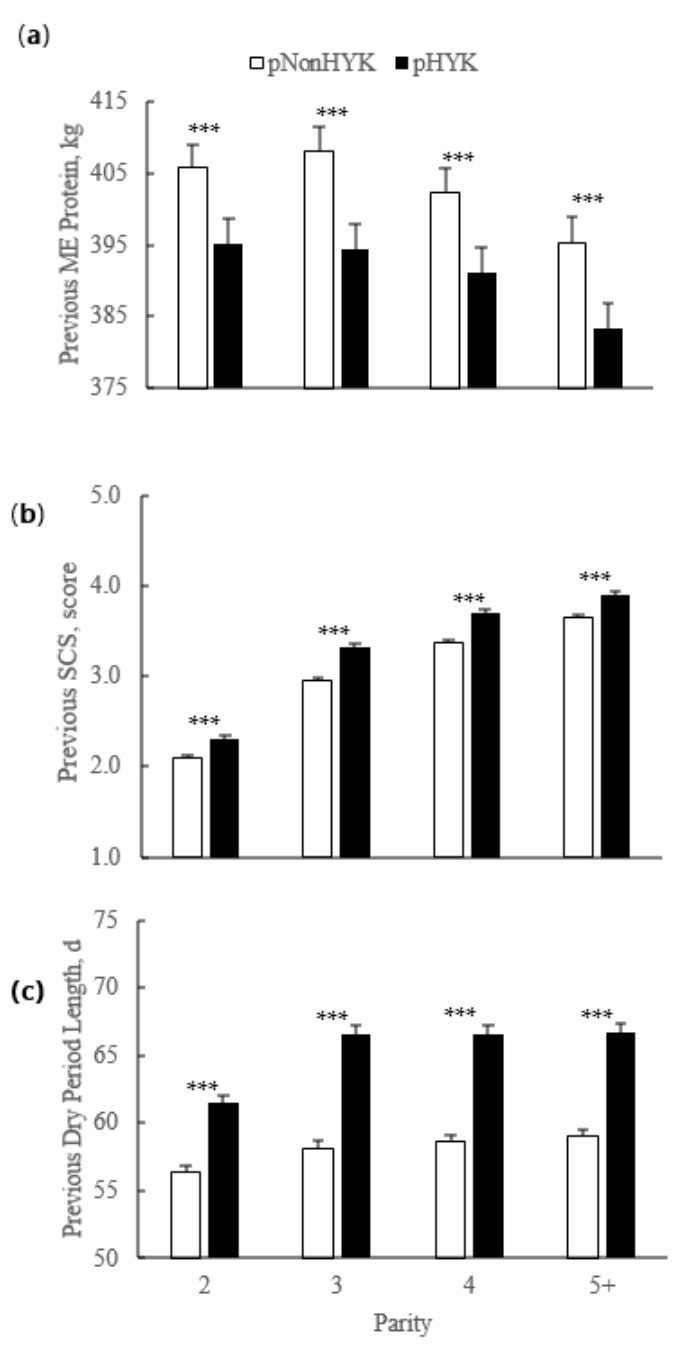
Figure 2. Parity by predicted hyperketonemia (HYK) status interaction on previous lactation ( a ) mature equivalent (ME) milk protein yield (kg); ( b ) somatic cell score (SCS; score); and ( c ) dry period length (d). Blood ß-hydroxybutyrate (BHB) was predicted based on test day milk sample and production variables collected between 5 to 20 days in milk. Predictions were classified as predicted HYK (pHYK; predicted BHB ≥ 1.2 mM) or not (pNonHYK; predicted BHB < 1.2 mM) for analysis. Records per lactation: 1, 88,782; 2, 67,327; 3, 43,790; 4, 23,999; 5+, 16,816. Parity by predicted HYK interactions p < 0.001. Asterisks (***) indicate simple effect of classification ( p < 0.001) within